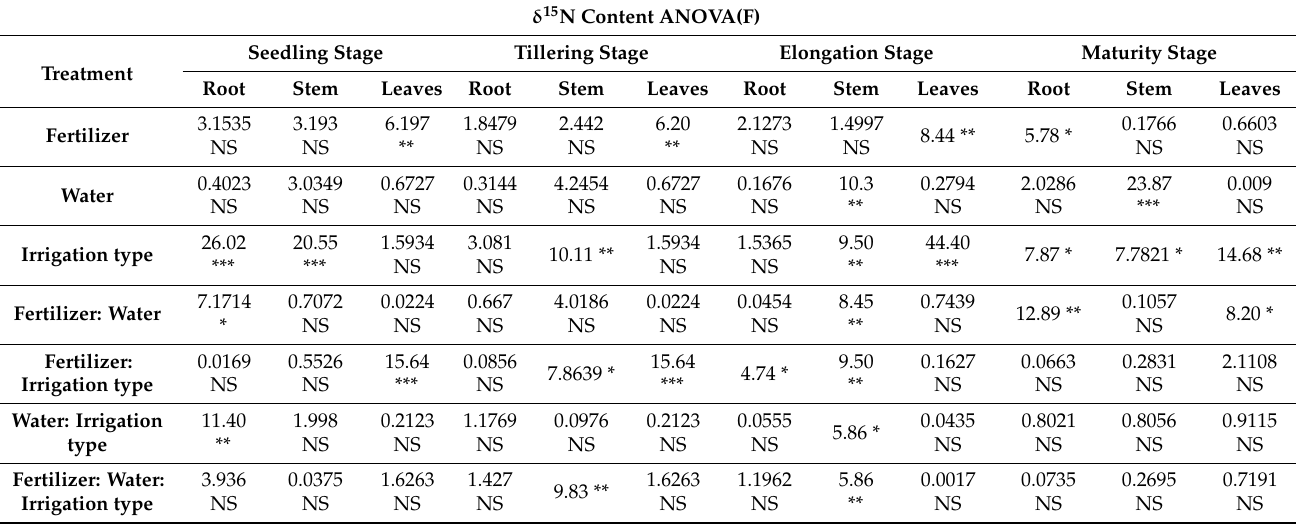
Table 3. Results of multivariate analysis of variance (ANOVA) of nitrogen isotope ( δ 15 N) content in sugarcane at different growth stages under different water-fertilizer-irrigation method treatments.